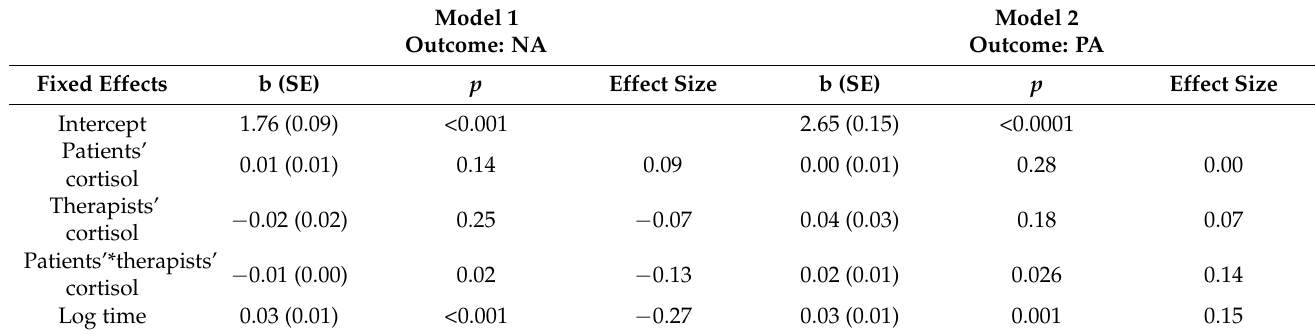
Table 3. Parameter estimates for the interaction between patients’ and therapists’ cortisol change predicting negative affect (Model 1) and positive affect (Model